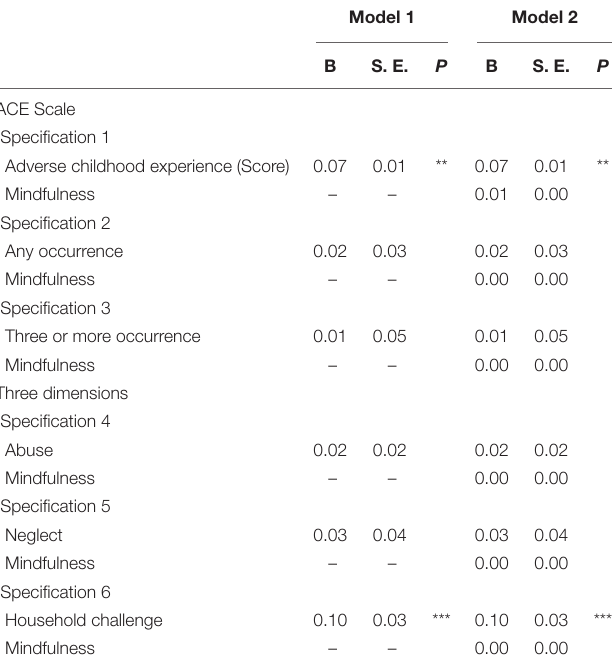
TABLE 6 | Robust tests of adverse childhood experiences (ACE) on grit subscale–consistency of